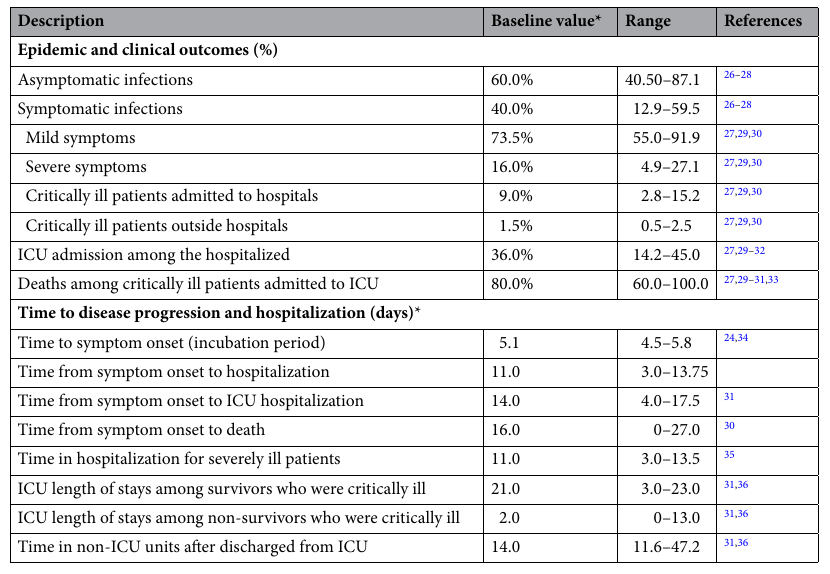
Table 2. Key parameters for the epidemic, clinical outcomes, and disease progression of COVID-19 in NYC. *The baseline values were primarily informed by the internal data from NYC DoHMH during